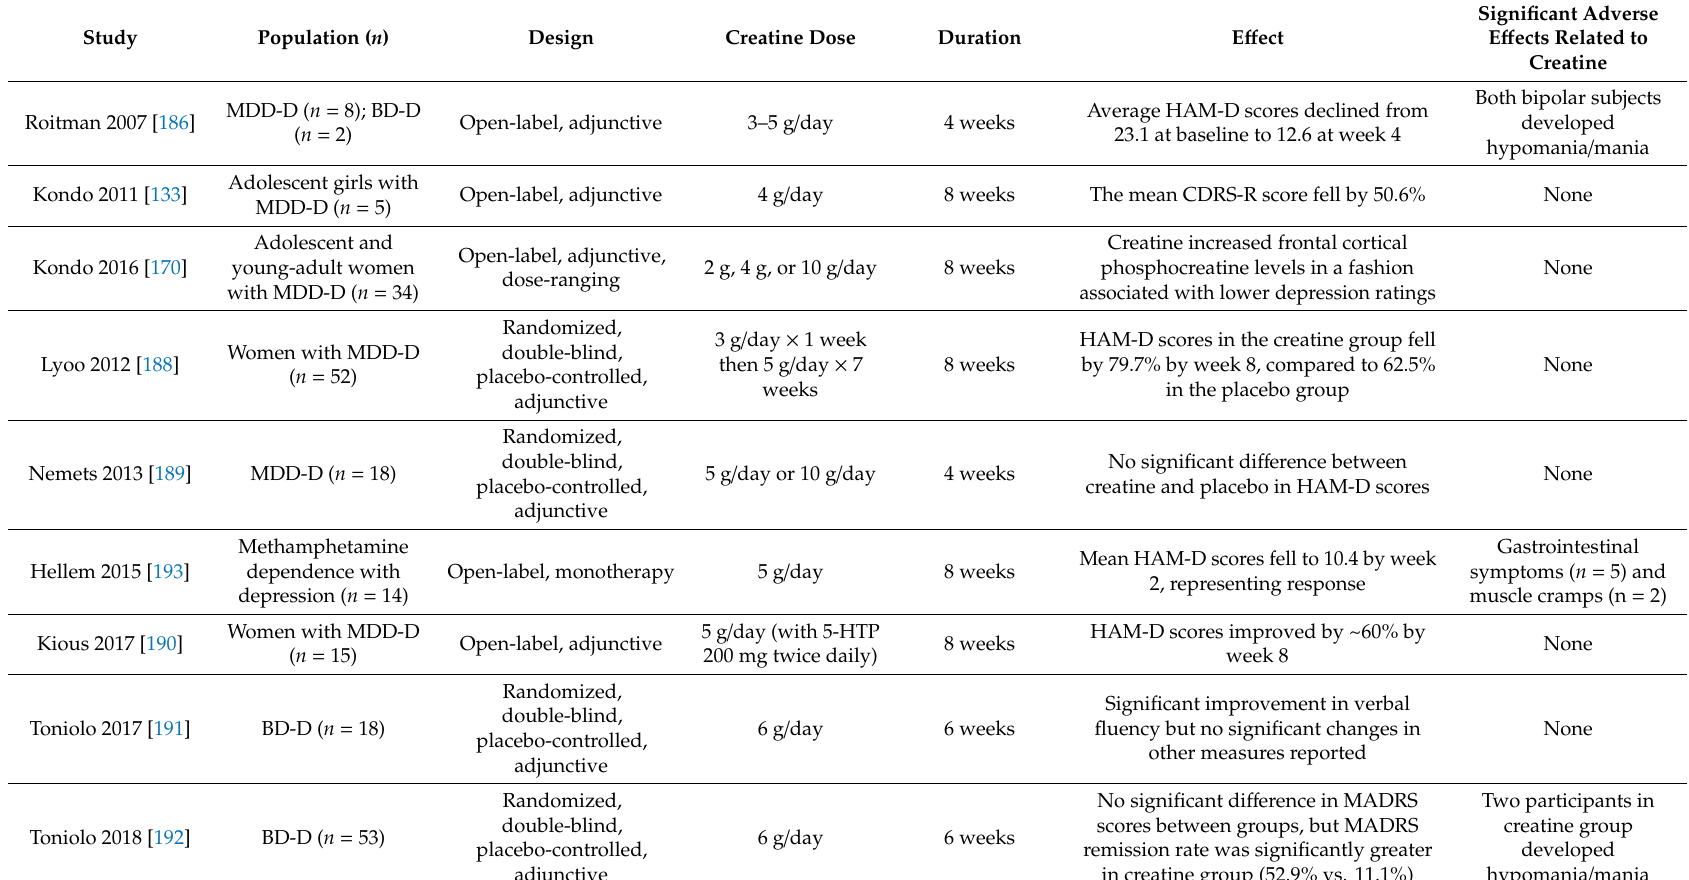
Table 2. Clinical trials involving creatine for the treatment of